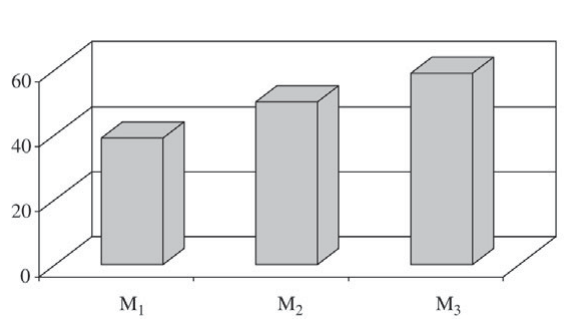
Figura 1. Factor material